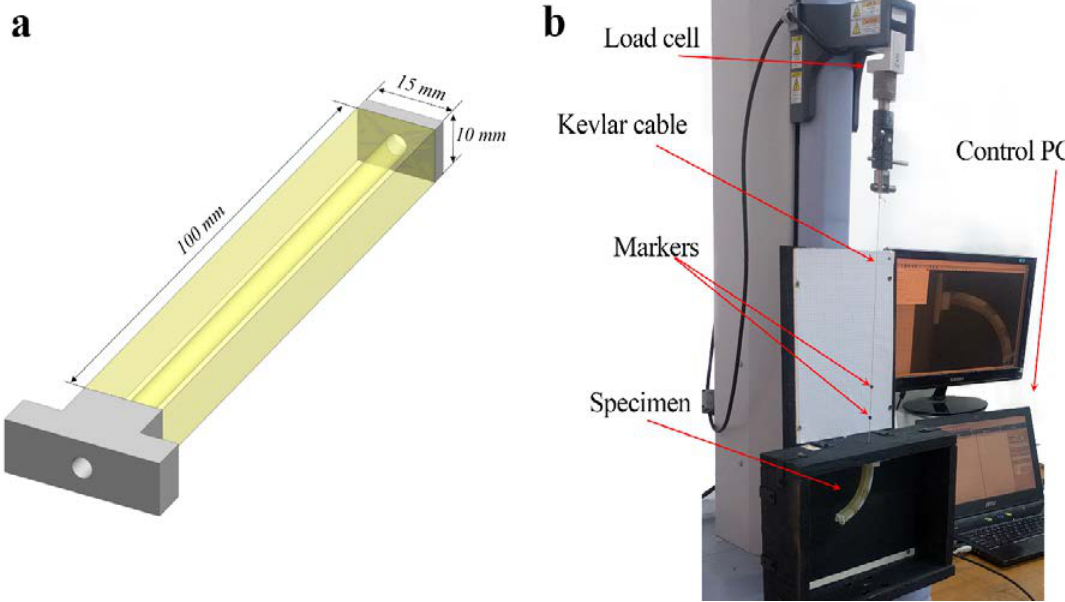
Figure 1. General geometry and dimensions of the actuator ( a ). The experimental setup for the testing ( b ).